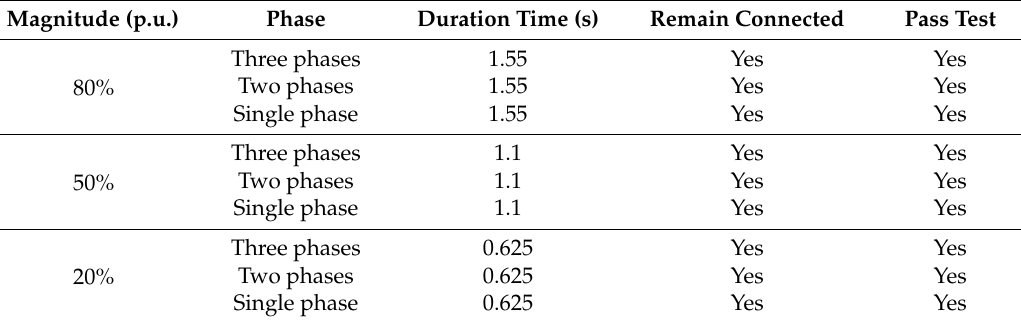
Table 7. LVRT standard testing results of PV inverter under different voltage